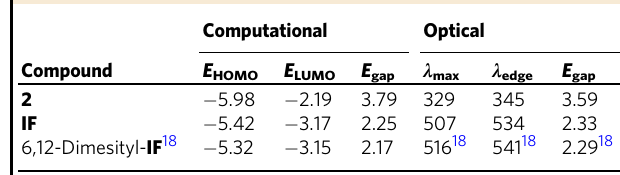
Table 1 Computational and optical data